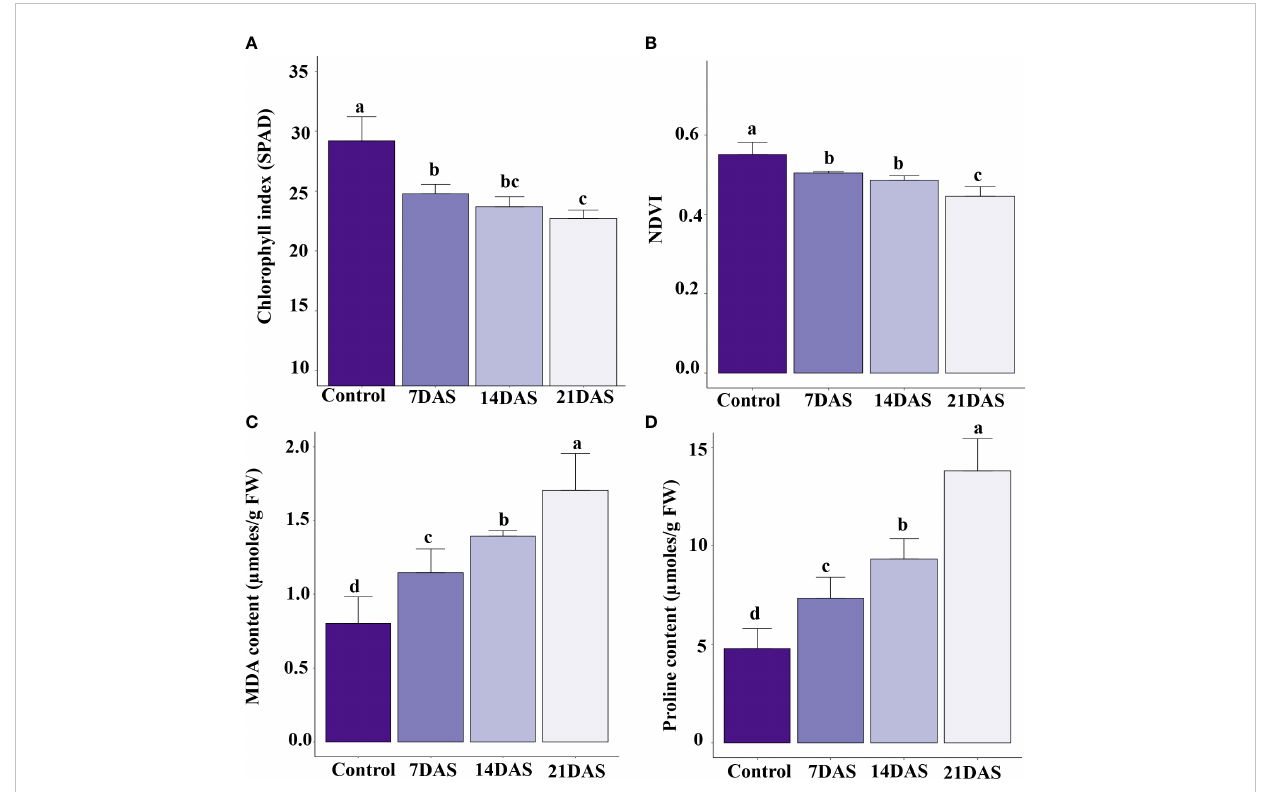
FIGURE 1 Physiological and biochemical changes in sugar maple saplings in response to drought stress: Sugar maple plants were subjected to drought stress for 7, 14, and 21 days and data were analyzed by comparison with the control samples. (A) Chlorophyll index (SPAD), (B) NDVI, (C) MDA, and (D)